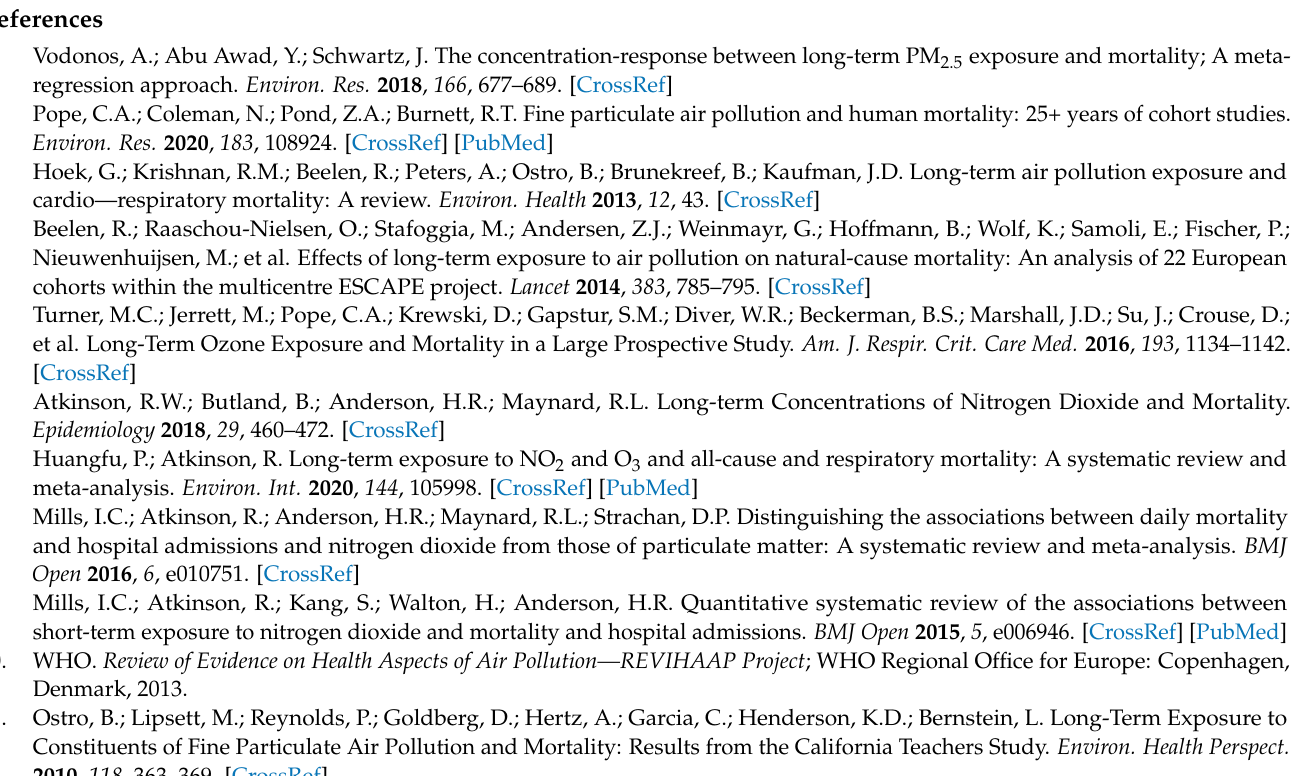
Figure S3a. Unadjusted hazard ratios for natural mortality per inter-quartile range (IQR), excluding individuals with missing information on covariates. Figure S3b. Unadjusted hazard ratios for CVD mortality per inter-quartile range (IQR), excluding individuals with missing information on covariates. Figure S3c. Unadjusted hazard ratios for respiratory mortality per inter-quartile range (IQR), excluding individuals with missing information on covariates. Figure S4a. Adjusted hazard ratios for natural mortality per inter-quartile range (IQR) in two-pollutant models; SIA, SOA and SS adjusted for total PM 2.5 , and mutually adjusted estimates for SIA and SOA. Figure S4b. Adjusted hazard ratios for CVD mortality per inter-quartile range (IQR) in two-pollutant models; SIA, SOA and SS adjusted for total PM 2.5 , and mutually adjusted estimates for SIA and SOA. Figure S4c. Adjusted hazard ratios for respiratory mortality per inter-quartile range (IQR) in two-pollutant models; SIA, SOA and SS adjusted for total PM 2.5 , and mutually adjusted estimates for SIA and